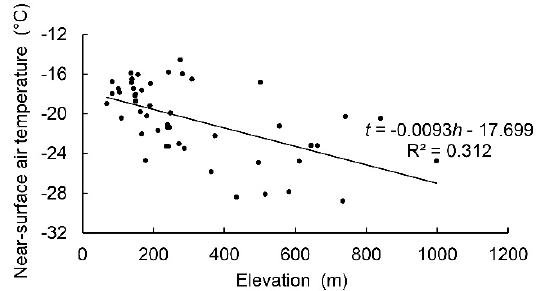
Figure 12. Scatter of elevation and near-surface air temperature in the northeastern parts of China in January, during 1981–2010. Elevation and near-surface air temperature are denoted by h and t in the equation of linear regression, respectively. A total of forty-nine meteorological stations were selected by using the same division standard as Li et al. [38], and the stations were located in the north at 45°N and in the east at 115°E.